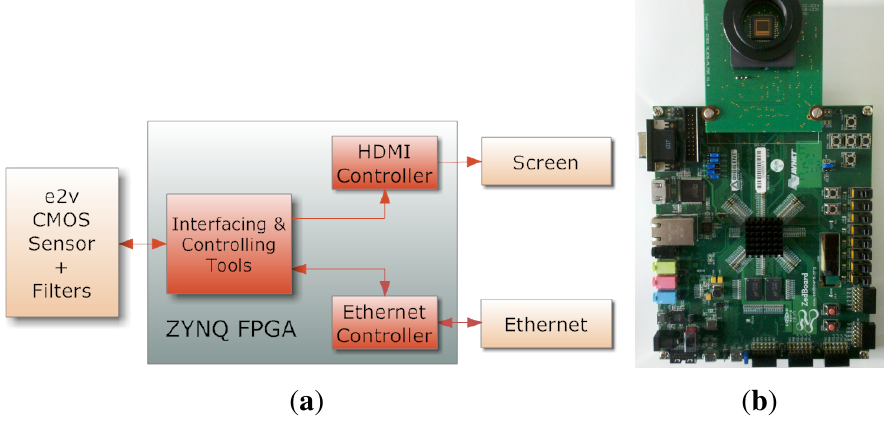
Figure 14. Overview of the hardware/software system integration, with a front view of the assembled camera without a lens ( b ); This camera architecture is used in order to test and